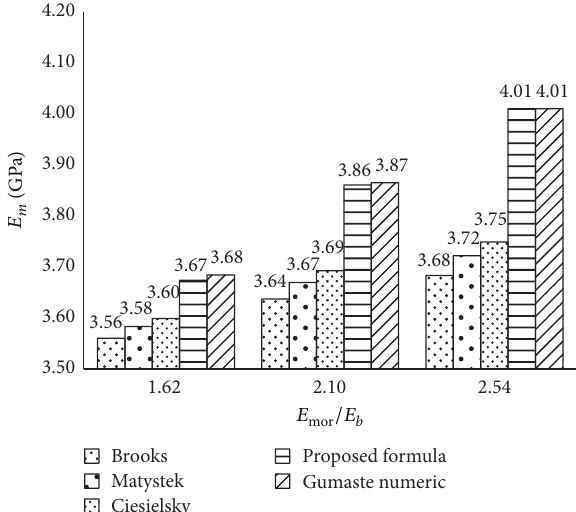
Figure 7: Comparison of equivalent elastic moduli based on Gumaste data ( 𝐸 mor > 𝐸 𝑏